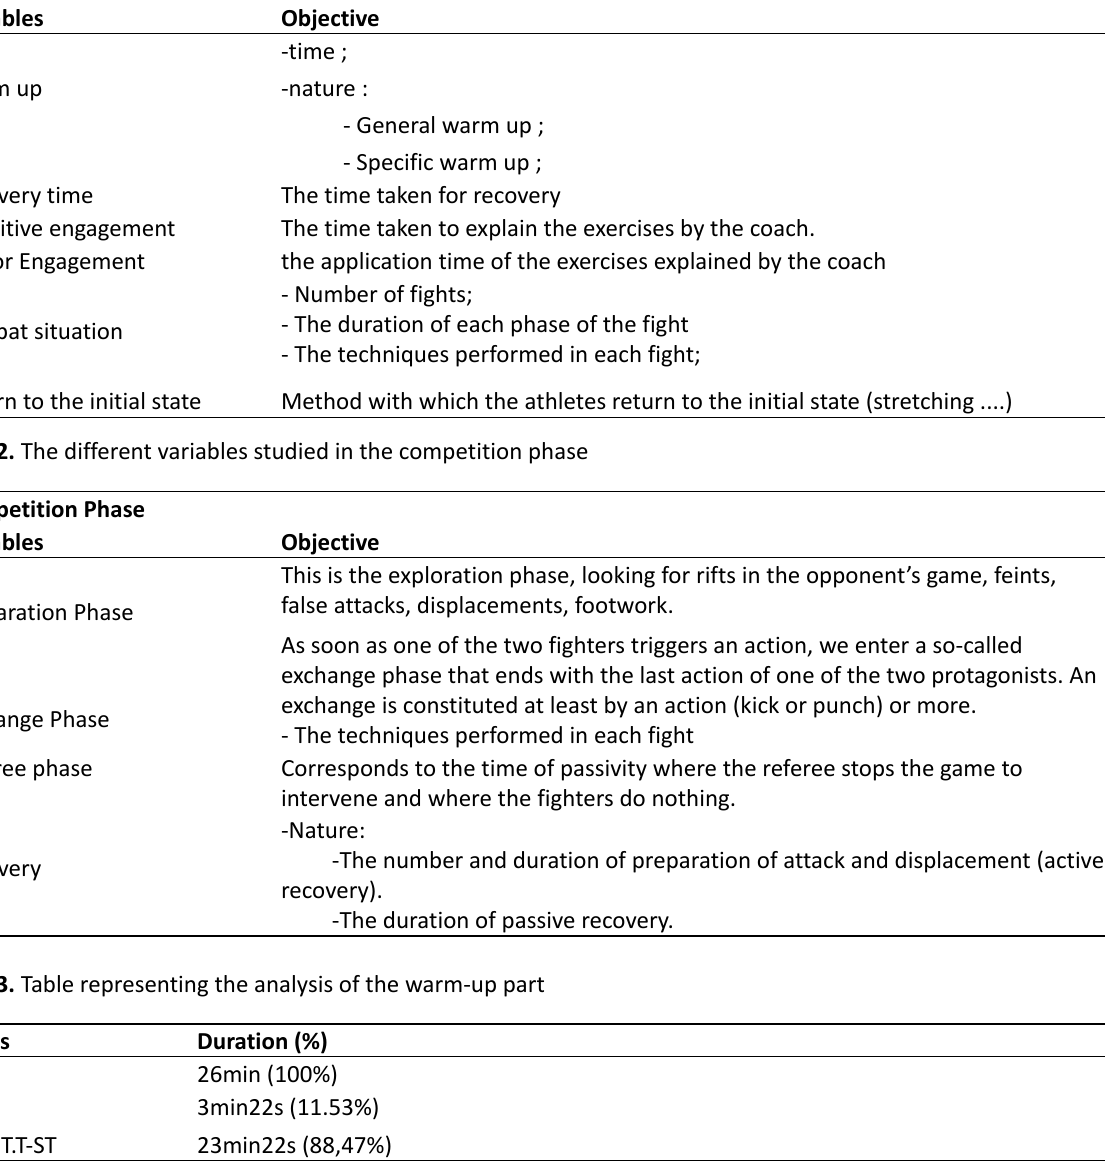
Table 1. The different variables studied in the training phase Training Phase: